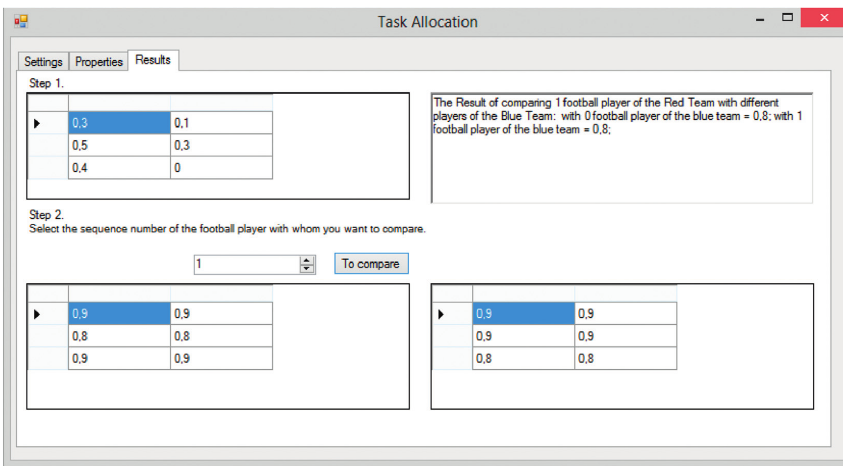
Figure 6: Result of the solution for the first MO of the red group.